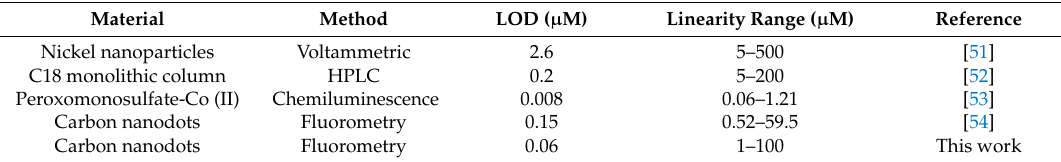
Table 1. Review of various approaches used for rifampicin assays.